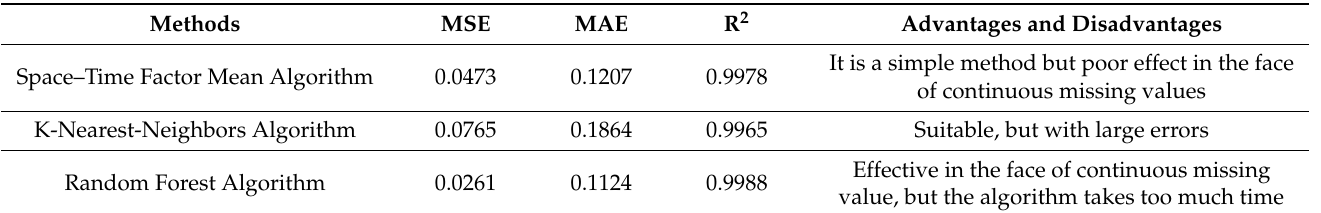
Table 1. Comparison and analysis of experiment results of the filling in of missing